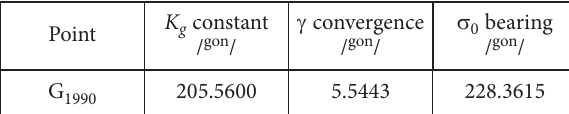
Table 8. Parameters specified at the MMB starting point